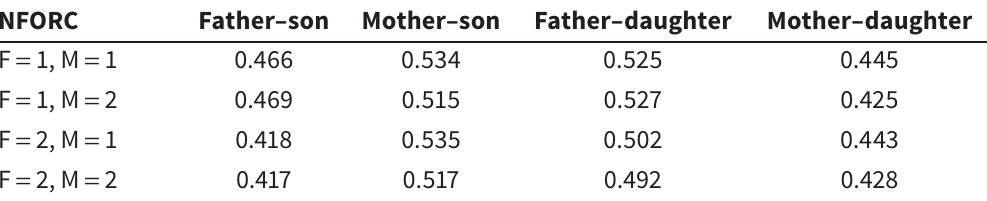
Average FSA by NFOR based on 41 major CIP codes